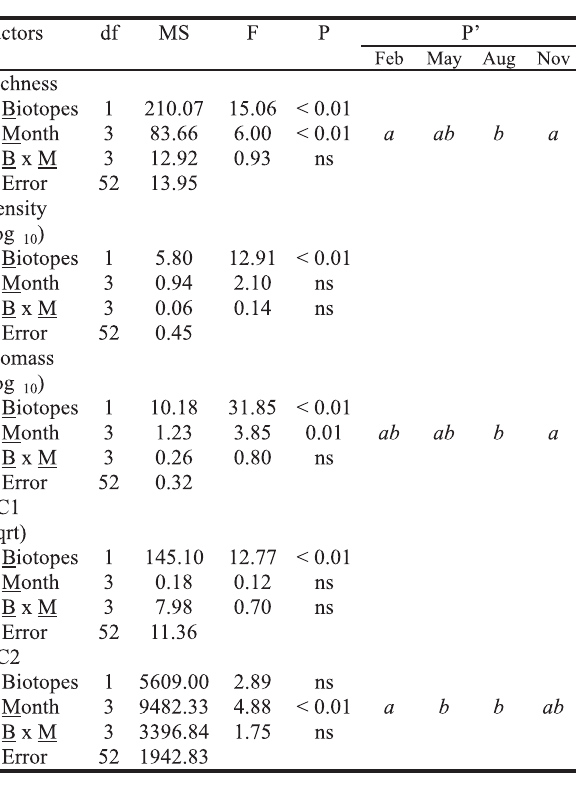
Table 1. Results of two-way ANOVAs applied to attributes (species richness, density, and biomass) and structure (scores from DCA axes 1 and 2) of the fish assemblage. Letters ( a and b ) identify averages that differed significantly between months according to Tukey’s Test (P’).